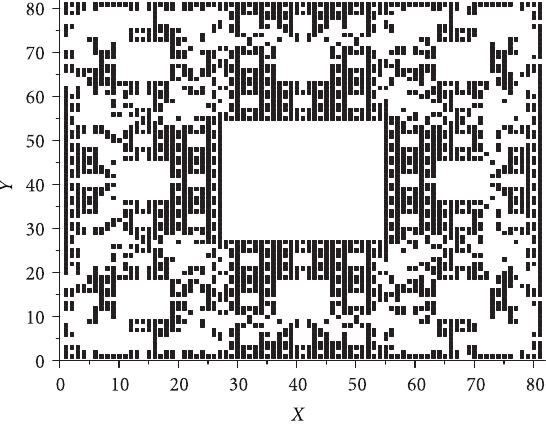
Figure 10: Optimized array structure for the second example.